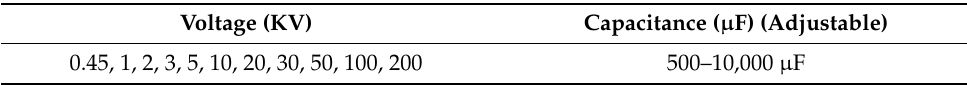
Table 3. The parameters of the electromagnetic pulse compaction device.